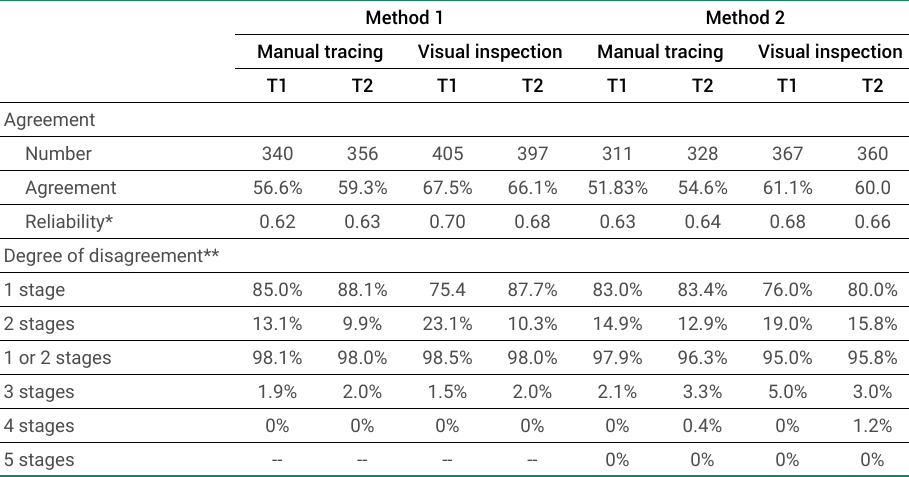
Table 4. Interexaminers reliability and agreement and distribution of the disagreements in accordance to the number of CVM stages in